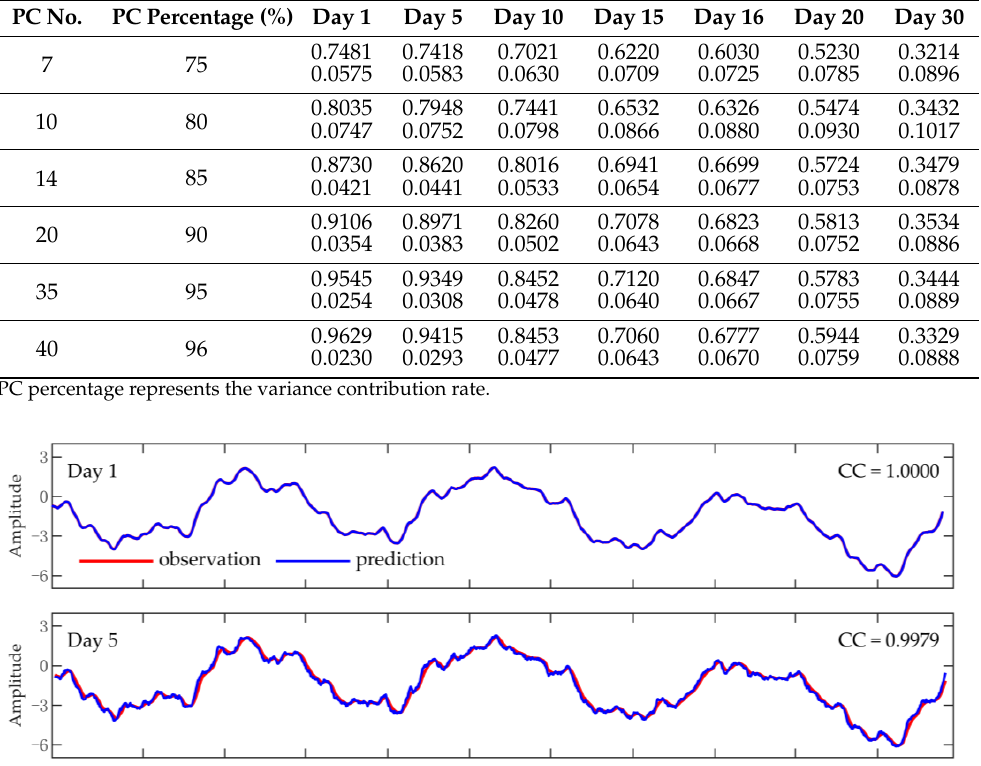
Table 1. Time-averaged correlation coefficient (blue numbers) and RMSE (m) of different quantities of PCs of the SCS SLA between predicted and observed from 18 April 2014 to 31 December 2017. The first column is the number of PCs. The second column is the variance contribution rate for different PCs. PC No.